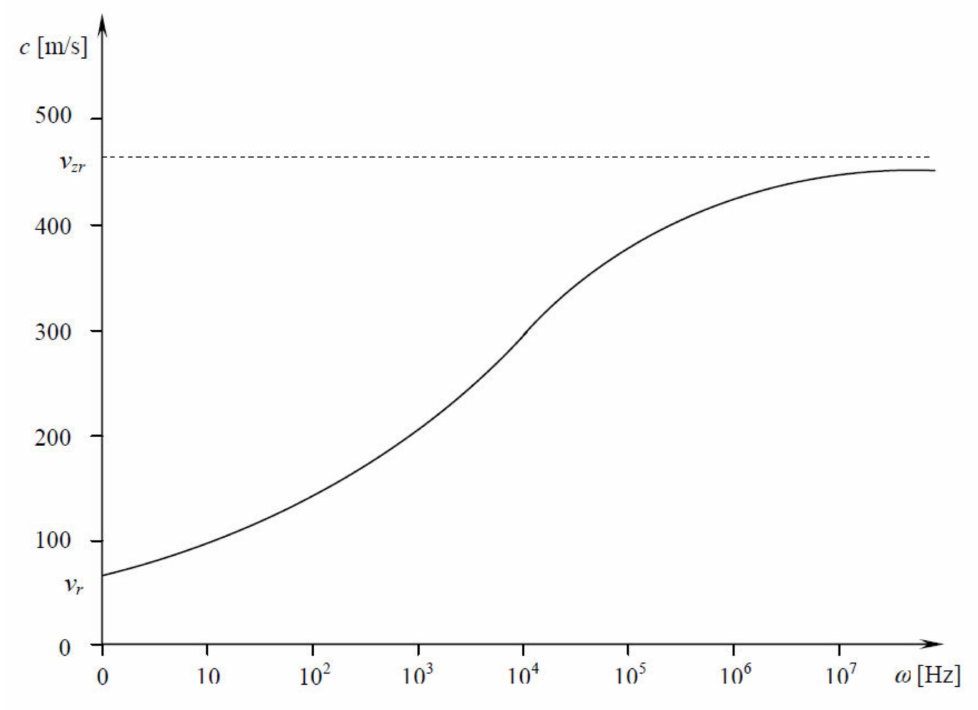
Figure 1. Course of the dispersion relationship for two-phase flow in conventional channels [24]. Importantly, apart from dispersive interactions , the irreversible phenomena of dissi- pative interactions occur during condensation in channels under conditions of dynamic instability. Interactions of this nature involve problems with the irreversibility of processes, leading to an increase in entropy and a suppression of disturbance propagation in